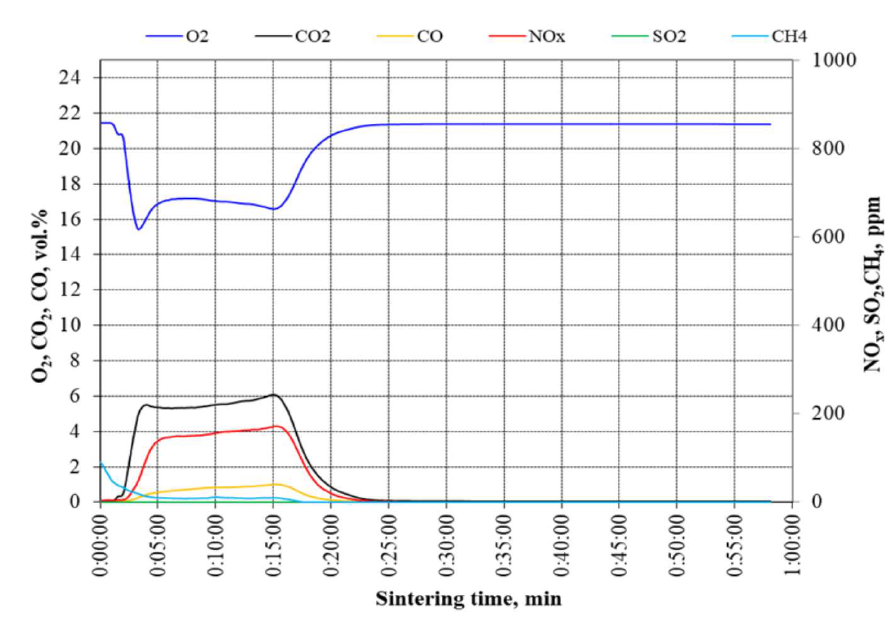
Figure 6. An exemplary composition of exhaust gas on the clean side during sintering with fuel mixtures with biochar.